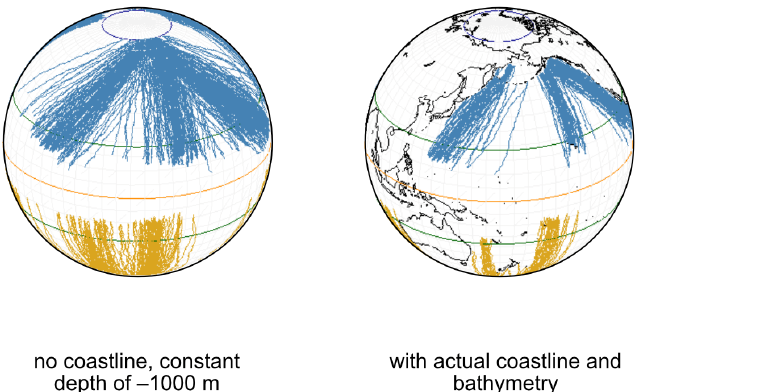
Figure 6. Examples of the routes followed by individual whales from their winter breeding grounds to the higher summer feeding grounds. In blue, the Northern Hemisphere, in orange, the Southern Hemisphere. The left figure shows a simulation performed in a configuration where the depth of the ocean was constant ( − 1000.0 m) without any emerged land. The right figure shows a simulation performed in the configuration of the actual Earth topography, estimated at 1 arc-minute resolution. The equator (orange line), the tropics (green lines) and the summer boundaries of the Ice Packs in the Arctic and the Antarctic were